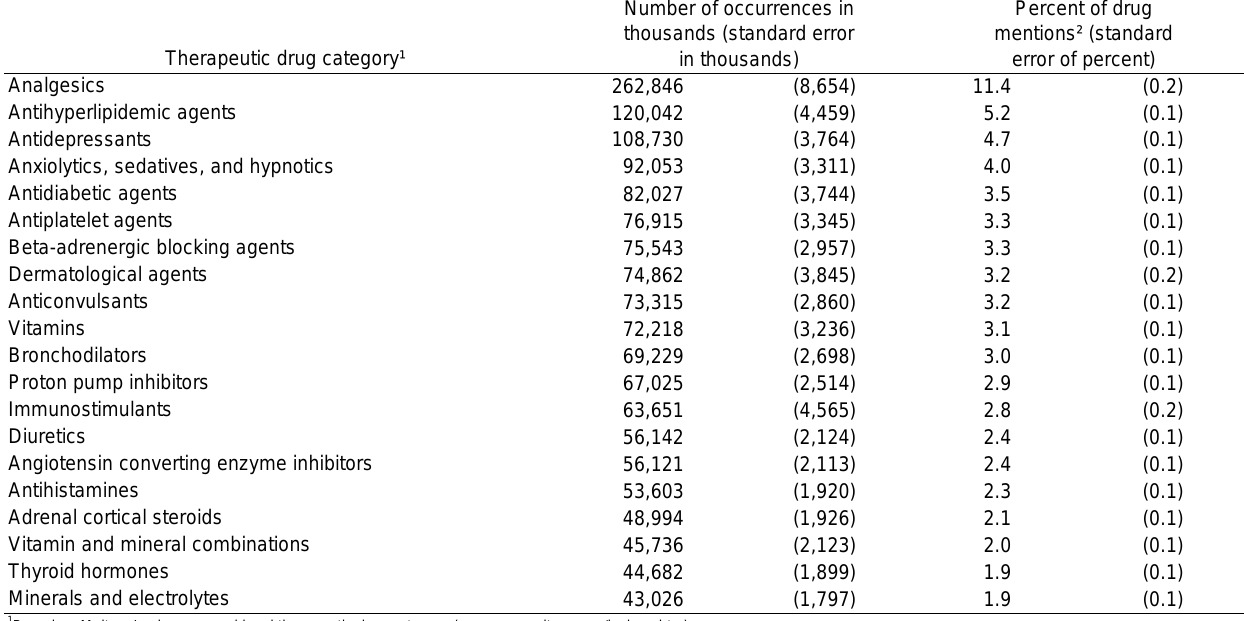
Table 25. Twenty most frequently mentioned drugs by therapeutic drug category at office visits: United States,